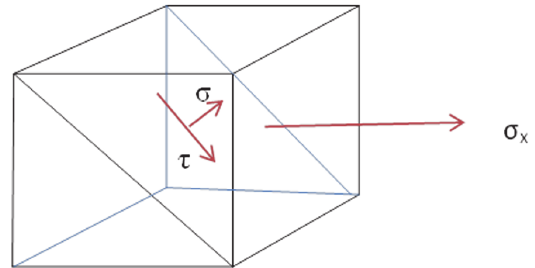
Figure 3: Stress situation in the material for a rod subjected to tension in